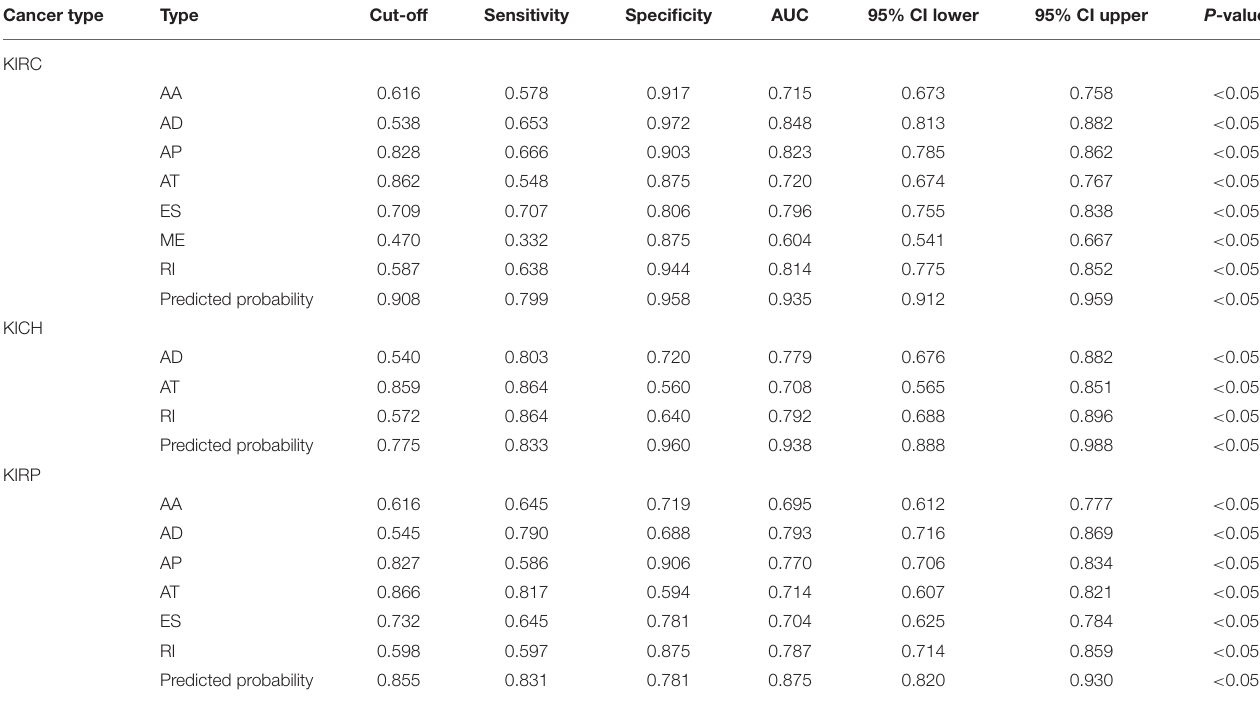
TABLE 7 | ROC curve results of PSI of each AS types in diagnostic test. Cancer